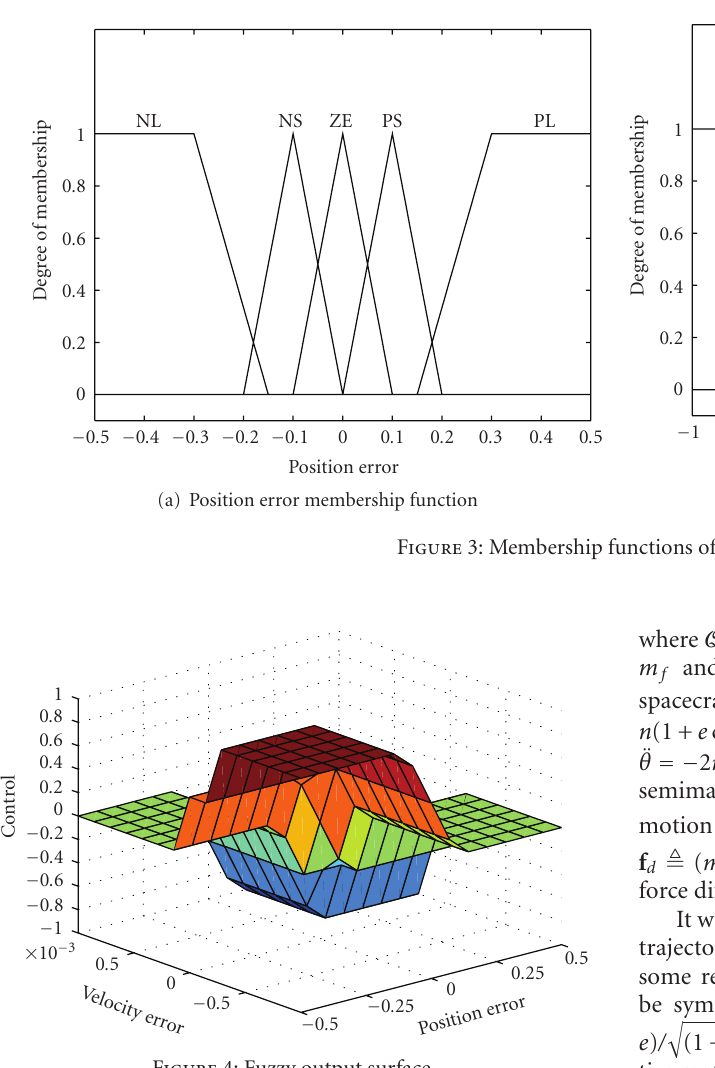
Figure 4: Fuzzy output